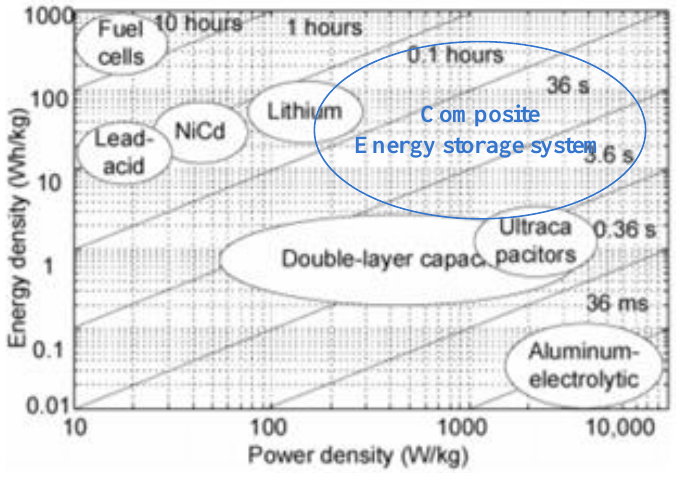
Figure 6. Energy density versus power density of different storage technologies.